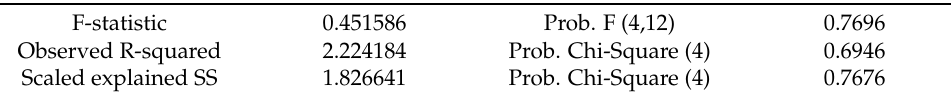
Table 3. Heteroskedasticity Test: Breusch-Pagan-Godfrey.